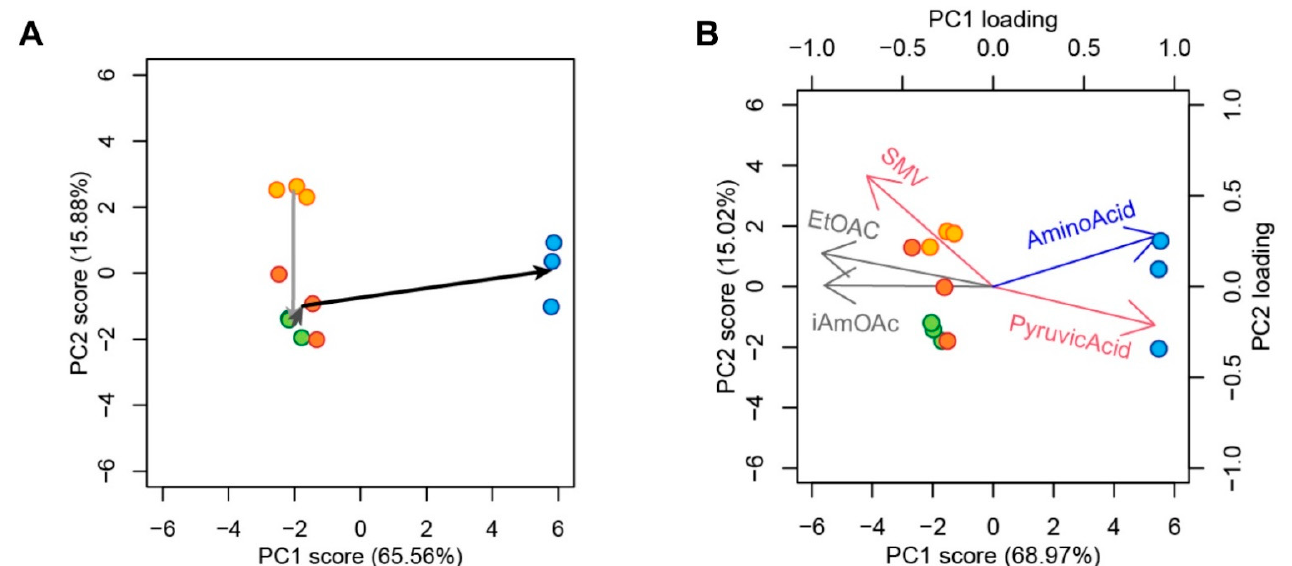
Figure 5. Principal component analysis (PCA) of sake produced by genome-edited yeast strains. Distribution of genome- edited yeast strains in the PC1–PC2 orthogonal space after performing PCA with 19 components ( A ). K7GE01 (yellow), K7GE21 (green), K7GE31 (orange), and K7GE41 (blue) were generated in that order. Distribution of sake components in the PC1–PC2 space after performing PCA with 16 components (without the three intentionally changed components) ( B ). Pyruvate and sake meter value (SMV) (red), ethyl acetate and isoamyl acetate (grey), and amino acidity (blue) are shown as arrows.